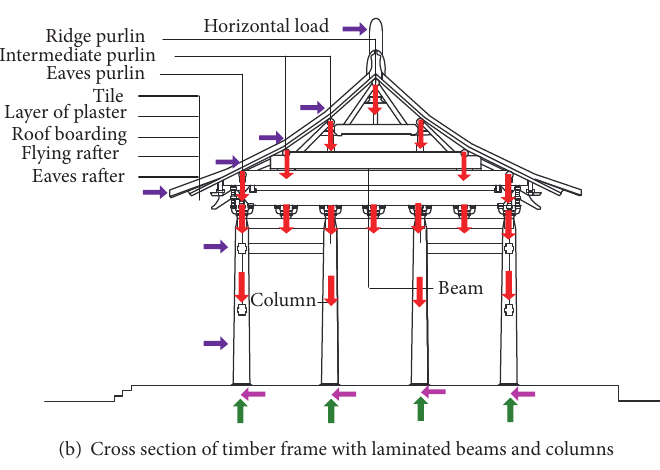
Figure 2: Timber frame with laminated beams and columns.